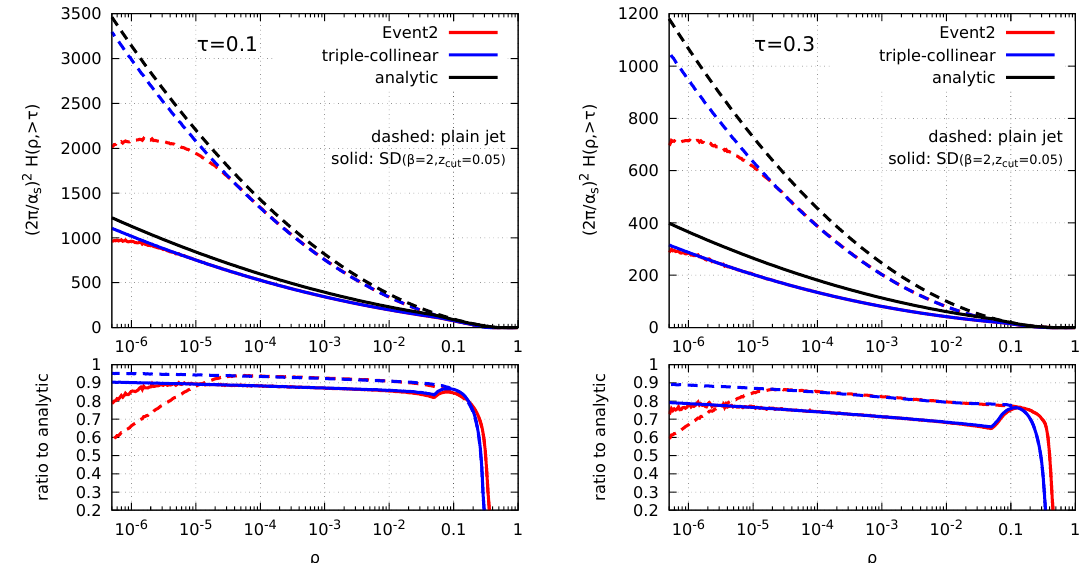
Figure 4 . Comparison of our analytic results with the Event2 generator and with the triple-collinear splitting function for the H ( (cid:26); > (cid:28) ) distribution. Dashed and solid lines respectively correspond to results obtained using plain and SoftDropped jets. The top panel shows H ( (cid:26); > (cid:28) ) and the bottom panel shows the ratio to our analytic results. The left and right plots correspond to a cut (cid:28) = 0 : 1 and (cid:28) = 0 : 3, respectively.